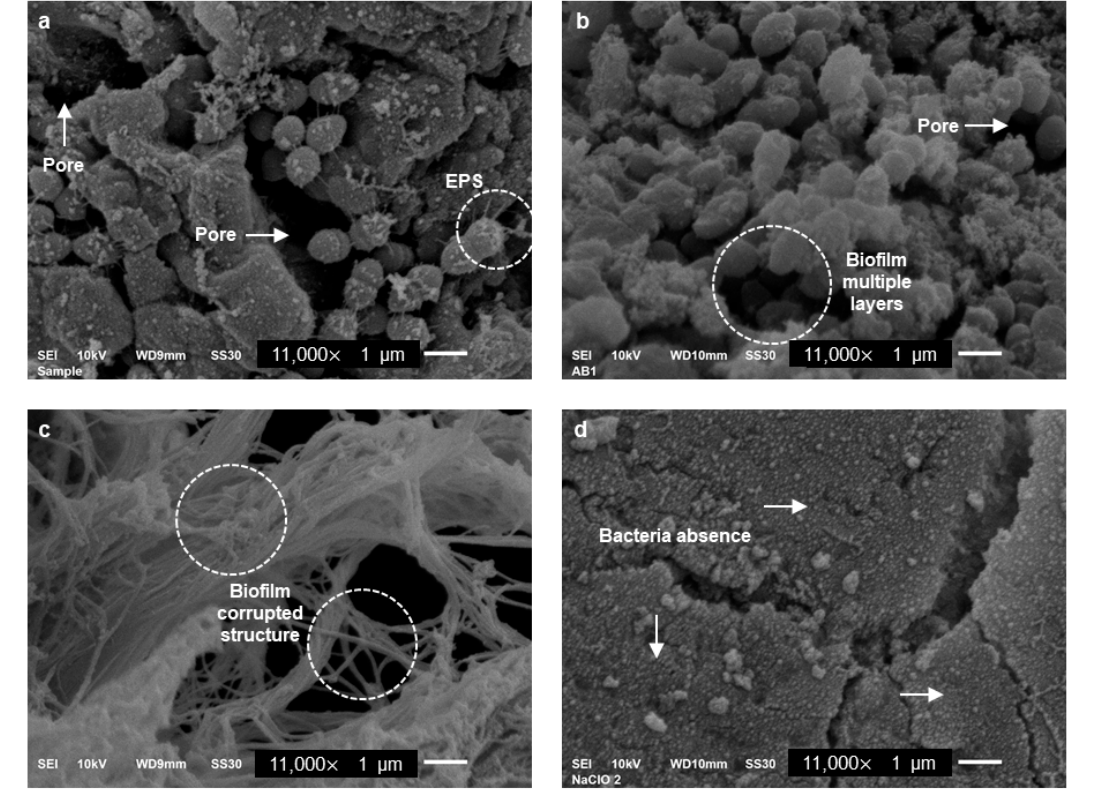
Figure 3. Presence of periapical biofilms after irrigation. The micrographs show the biofilms accord- ing to the treatment. ( a ) Untreated negative control group. ( b ) AmC treated group. ( c ) CEL-AmC treated group. ( d ) NaOCl treated group. EPS, extracellular polymeric substances; AmC, amoxi- cillin/clavulanic acid; CEL, cellulase; CEL-AmC, a combination of CEL/amoxicillin/clavulanic acid.